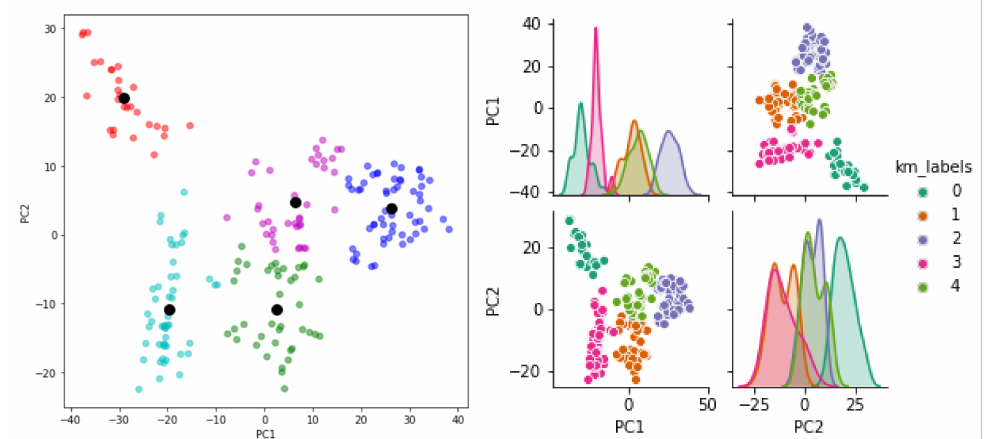
Figure 12. PCA and K-means clustering—flow rate and pressure data.